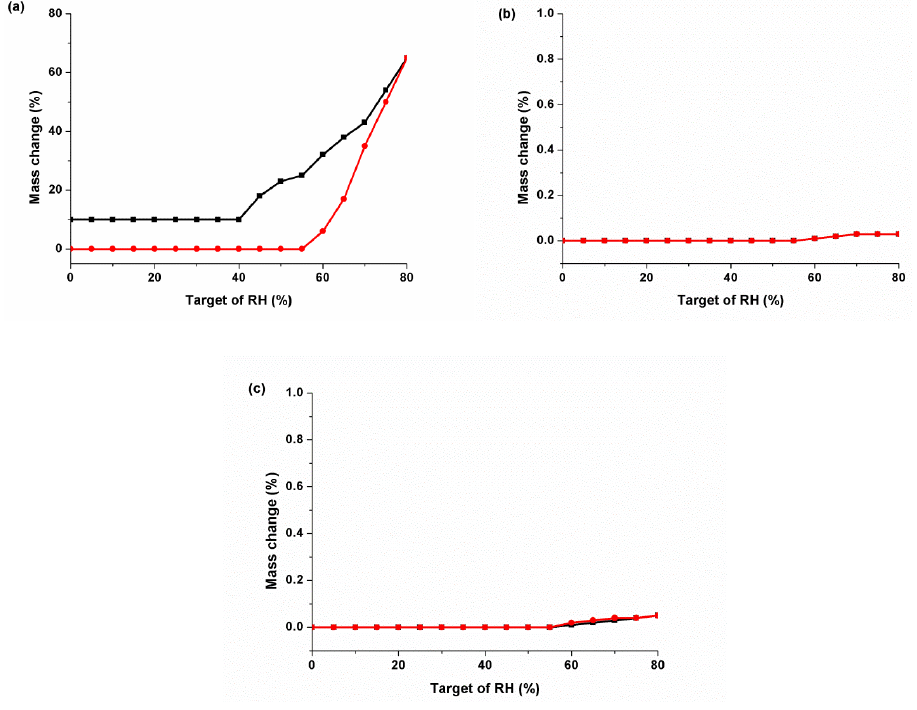
Figure 9. Dynamic vapor sorption charts of ( a ) Met, ( b ) Gli, and ( c ) Gli-Met. The red and black symbols represent absorption and desorption, respectively.